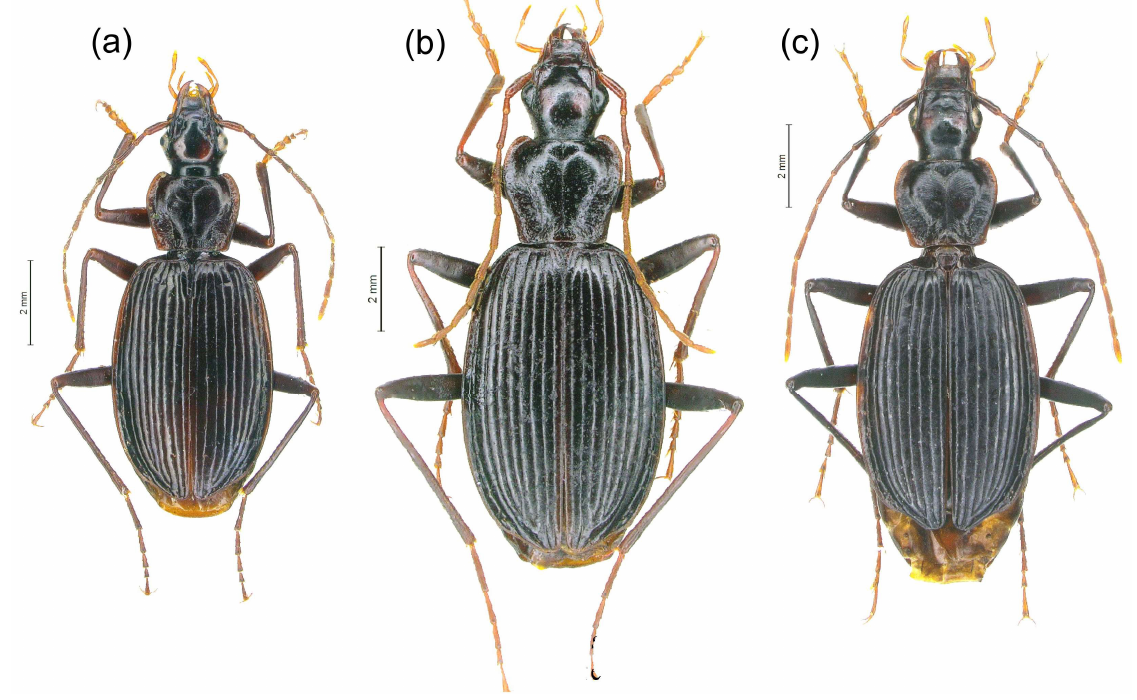
Figure 16. Habitus of Platynus species: ( a ) P. erythrocephalus ; ( b ) P. simonisi n. sp. ; ( c ) P. complanatus .